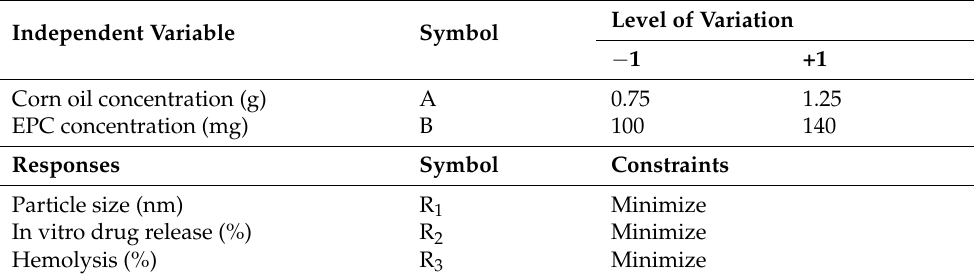
Level of Variation − 1 +1